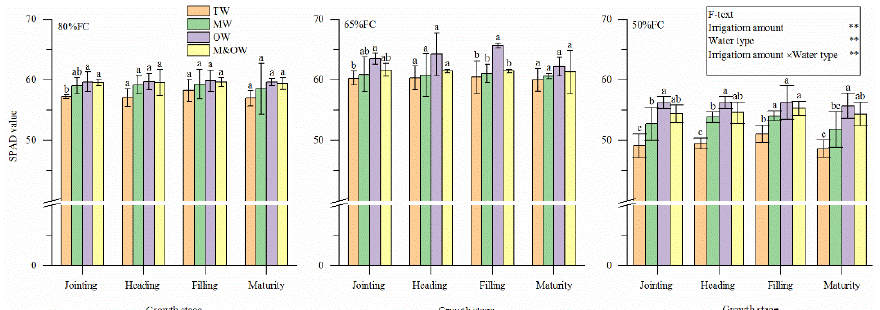
Figure 5. Effect of tap water (TW), magnetized water (MW), oxygenated water (OW), and magnetized and oxygenated water (M&OW) irrigation on SPAD value of winter wheat with 80%FC, 65%FC, and 50%FC irrigation amounts in the different growth stages. Different letters above the bars indicate significant differences among treatments in the different growth stages at p < 0.05. Irrigation amount × water type represents the effect of interaction between irrigation amount and water type. ** identifies significant differences at p < 0.01, respectively, and ns identifies no significant differences. The error bars indicate standard deviations.